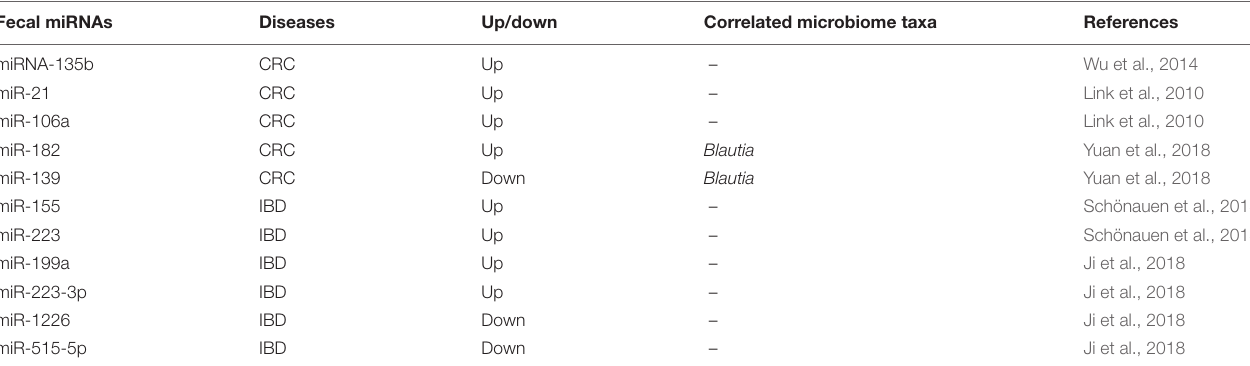
TABLE 2 | Fecal miRNAs and bacteria correlated with them in different gastrointestinal